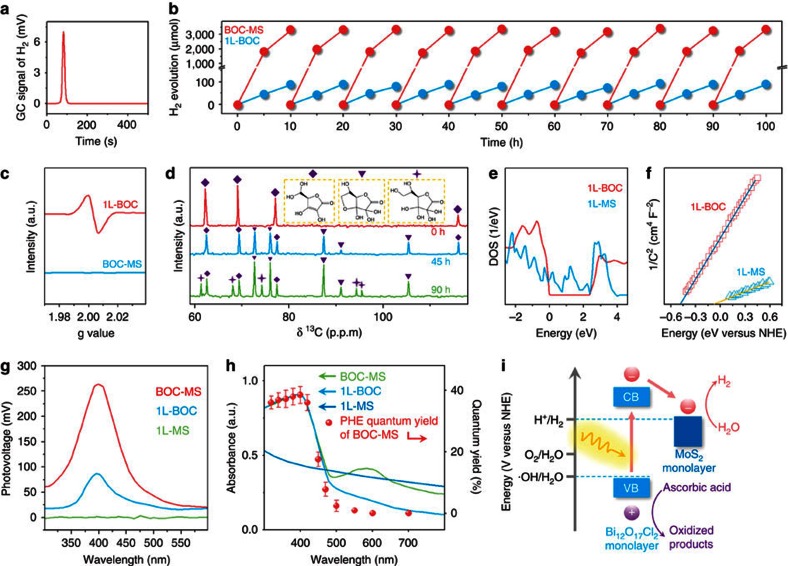
Evaluation of visible light PHE performances of BOC-MS.(a) A typical GC signal of H2 formed from BOC-MS involved
PHE system. (b) Cycling tests of PHE over BOC-MS and 1L-BOC. Reaction
conditions: 10 mg catalysts; 0.3 mol l−1
ascorbic acid; visible light (λ>420 nm). The
reaction cell was evacuated each 10 h without renewing ascorbic acid
solution. (c) EPR spectra of 1L-BOC and BOC-MS. (d) 13C NMR spectra of the solutions containing BOC-MS and ascorbic
acid after 0, 45 and 90 h of PHE experiments. (e) DOS and
(f) Mott–Schottky plots of 1L-BOC and 1L-MS. (g)
Surface photovoltage spectroscopy of 1L-BOC, 1L-MS and BOC-MS. (h)
Ultraviolet–visible diffuse reflectance spectrum of BOC-MS, 1L-BOC and
1L-MS, and PHE quantum yields of BOC-MS plotted as a function of wavelength
of the incident light. (i) Band alignments in 1L-BOC and 1L-MS.